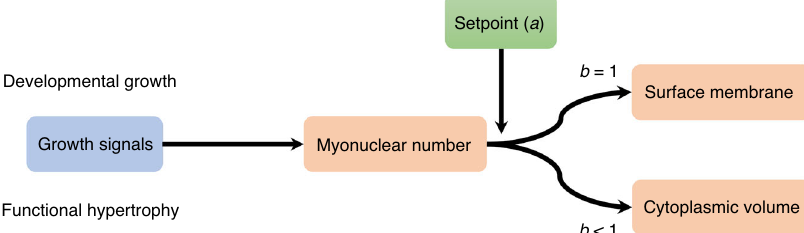
Fig. 8 Model for regulation of muscle fi bers size related to scaling relationship. Our model proposes that the number of myonuclei in a fi ber segment is determined by growth signals during development and hypertrophy. The number of nuclei and a setpoint a (which is a productivity number for each nucleus) determine cellular dimensions. The number of nuclei scales invariably sublinearly to cell volume ( b < 1), but linearly to cell surface ( b =